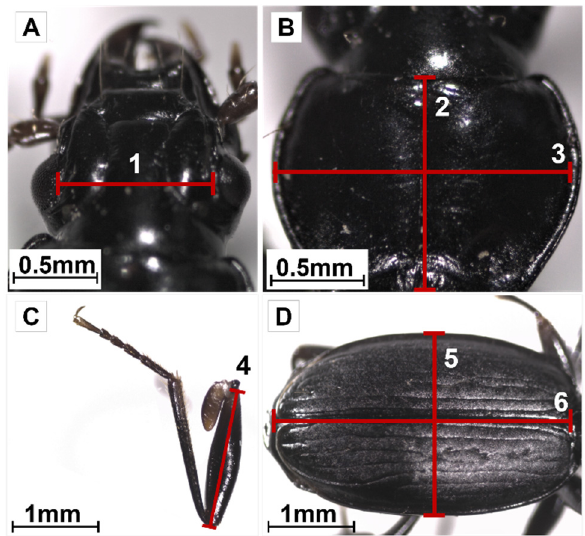
Figure 2. Morphometric measurements performed on adults of Amblystogenium pacificum . The illustrations were made on a male from the dark morphotype collected at 900 m asl. A - Head: interocular distance (1); B- Pronotum: length (2) and width (3); C- Left leg of the third pair of legs: length of the femur (4); D- Elytra: width (5) and length (6).